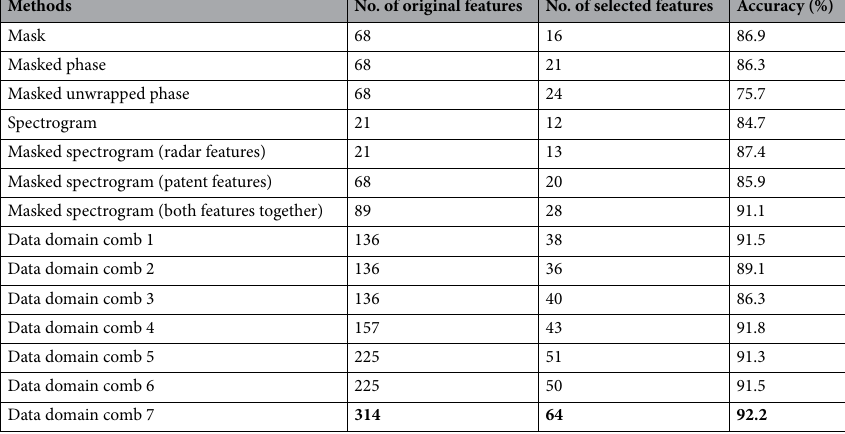
Table 12. Performance comparison using feature selection via SFFS (across different data domains and their combinations).